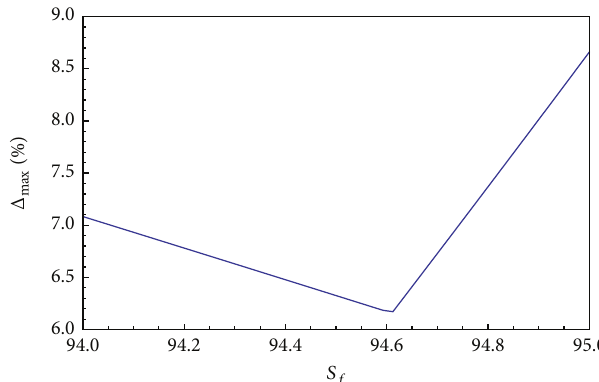
Figure 1: Fine-tuning the “screening factor” to minimize the maximum 𝑠 -PSF